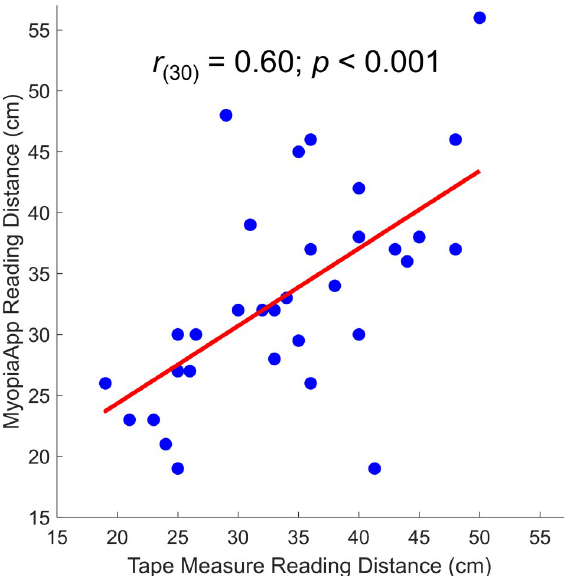
Fig 3. Correlations between reading distances obtained using tape measure and the use of a dedicated smartphone application.